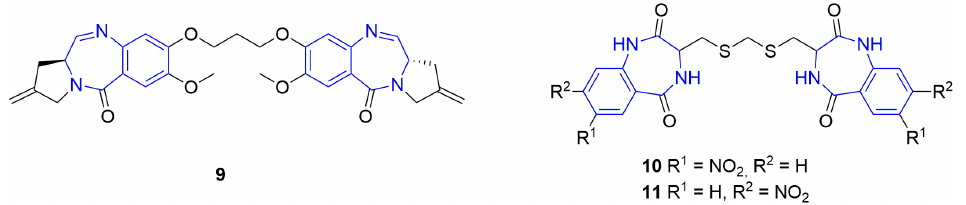
Figure 2. Dimeric benzodiazepines with anticancer activity. The benzodiazepine units are marked in blue. in